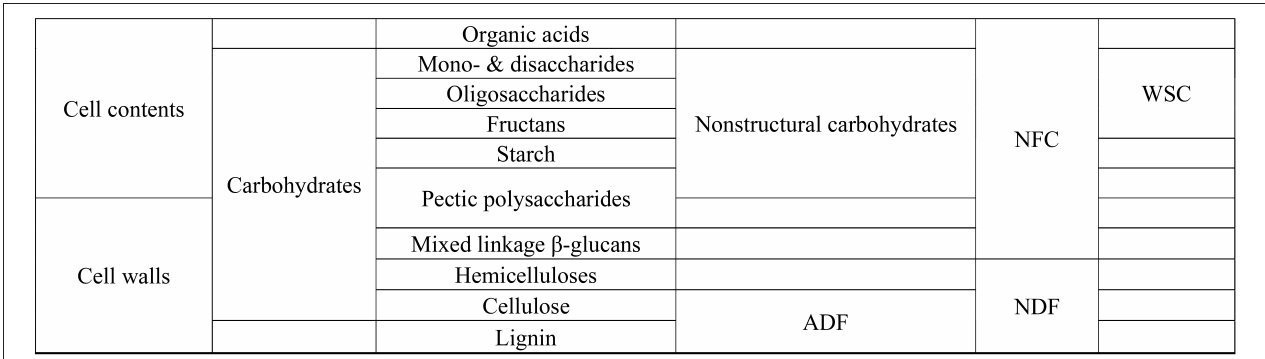
FIGURE 2 | Plant carbohydrates. ADF, acid detergent fibre; NDF, neutral detergent fibre; NFC, non-fibre carbohydrates; WSC, water soluble carbohydrates. Adapted from Hall et al.